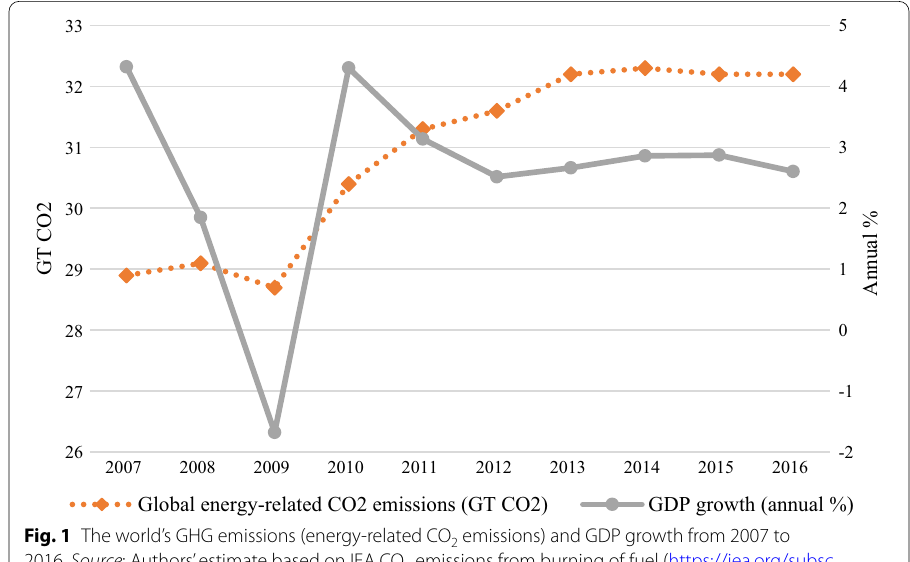
Fig. 1 The world’s GHG emissions (energy-related CO 2 emissions) and GDP growth from 2007 to 2016. Source : Authors’ estimate based on IEA CO 2 emissions from burning of fuel (https:// iea. org/ subsc ribe- to- data- servi ces/ co2- emiss ions- stati stics), World Bank national accounts data, and OECD national accounts data